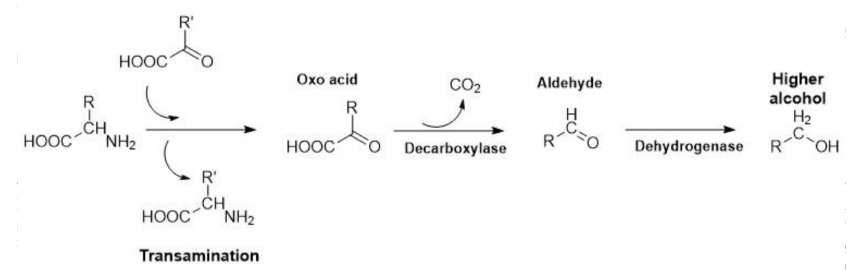
Figure 2. Scheme of higher alcohol synthesis according to the catabolic (Ehrlich)